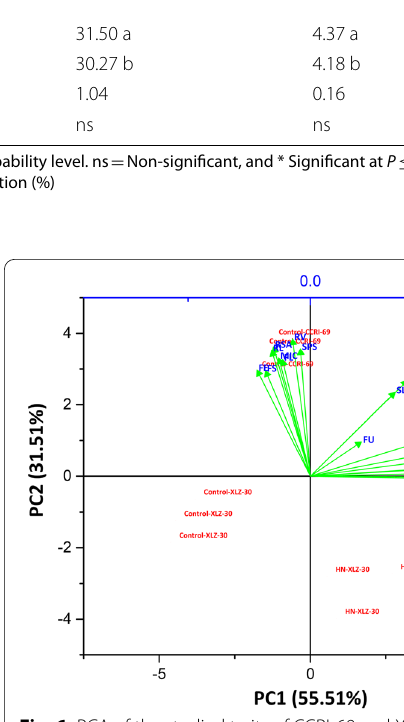
Fig. 6 PCA of the studied traits of CCRI-69 and XLZ-30 under the control (2.5 mmol L − 1 ) and high N conditions (5 mmol L − 1 ). The · · eigenvectors for PC1 and PC2 are shown in supplementary table Fig. 5 Relationships among various morphological and physiological traits (green) and fiber quality traits (red). Nodes and edges represent traits and correlation, respectively. Red and blue color edges show positive and negative correlations, respectively. Edges thickness represents the strength of the correlation, where strong positive correlations were highlighted by red ( r 0.99) color and strong = negative by green ( r 0.95 to 0.98) color. Root length (RL), root = − − surface area (RSA), root diameter (RD), root volume (RV), the number of leaves per plant (NOL), subtending leaf area per plant (SLA), subtending leaf biomass (SLB), subtending leaf N content (SLN), chlorophyll a (Chla), chlorophyll b (Chlb), carotenoid (CAR), free amino acid (FAA), total soluble protein (TSP), total soluble sugar (TSS),